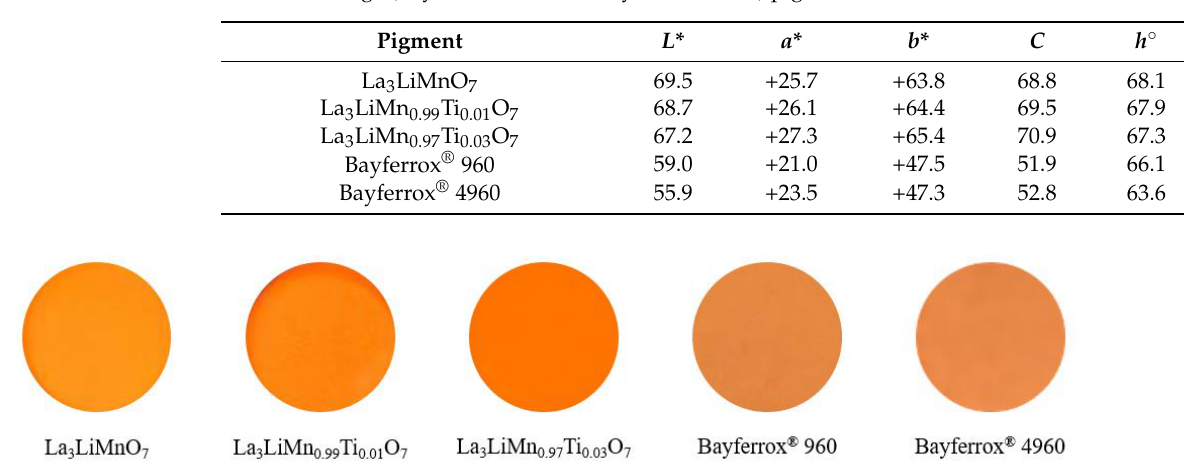
Figure 6. Photographs of the La 3 LiMn 1 − x Ti x O 7 (0 ≤ x ≤ 0.03) and commercially available orange Bayferrox ® 960 and Bayferrox ® 4960 pigments.